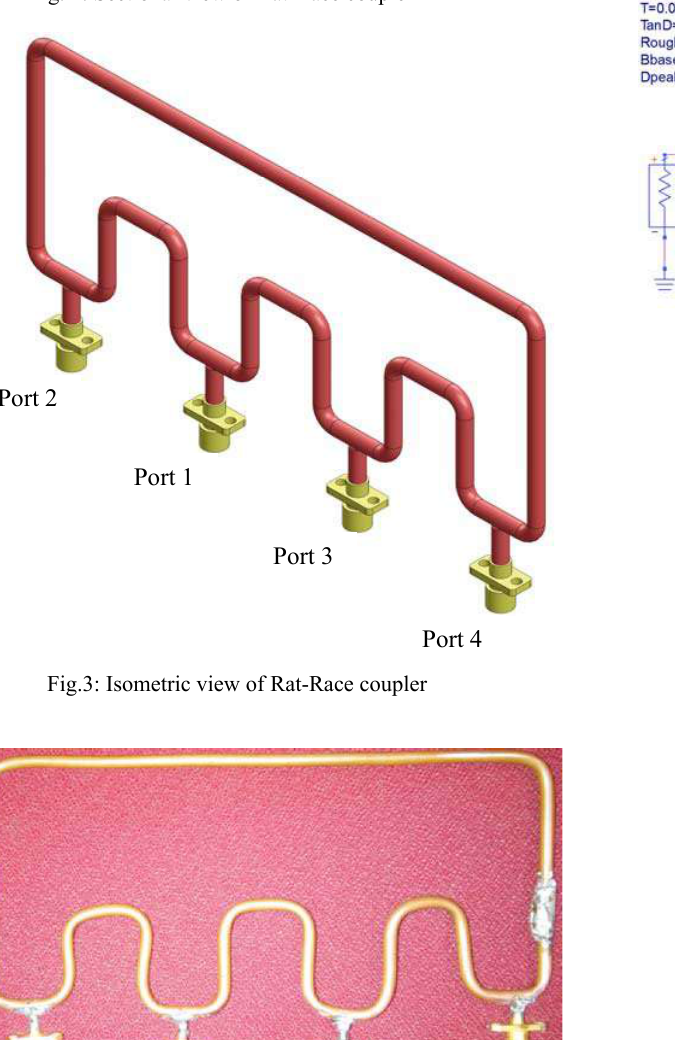
Fig. 2: Sectional view of Rat-Race coupler